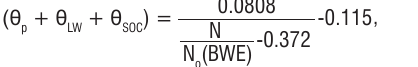
Calibrations, dates, gravimetric soil moisture, bulk density, neutron counts and calculated N